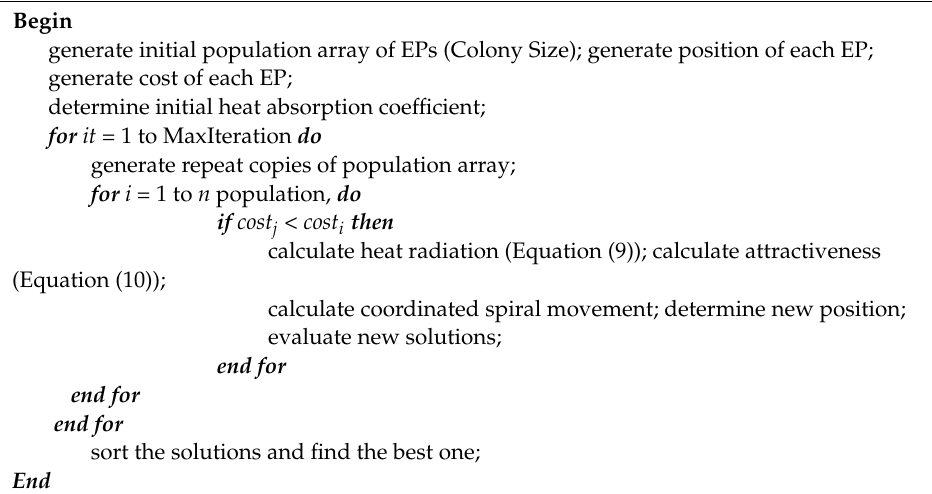
Algorithm 1: Pseudo-code of the EPC algorithm.